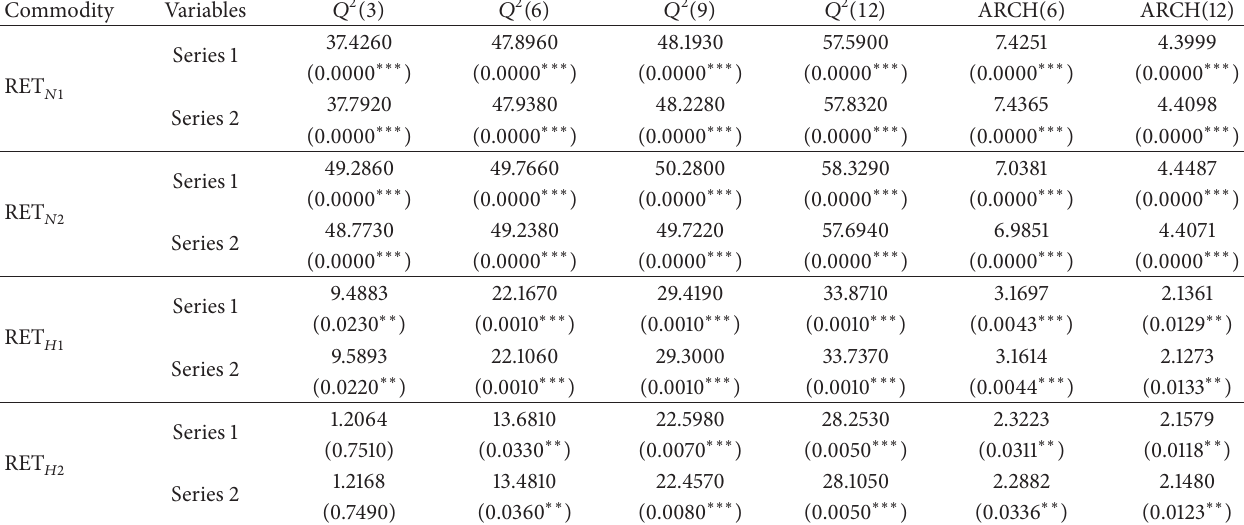
Table 3: Results for Ljung-Box 𝑄 2 and ARCH-LM